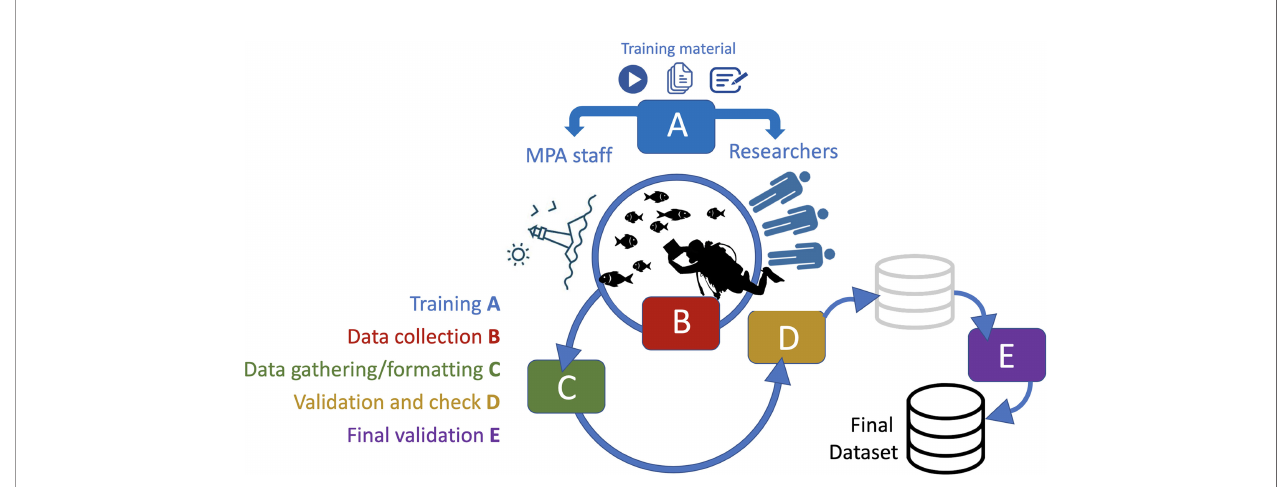
FIGURE 1 | ClimateFish work fl ow. Visual representation of the data curation, formatting, technical validation, and quality control process of the database: (A) Training sessions/materials were delivered to both MPA staff and collaborating researchers; (B) Data were collected by trained scientists and technicians, according to the protocol described in Garrabou et al. (2018) and checked before submission; (D) Formatted data were then examined for possible errors and underwent the technical validation process. The data providers were contacted in case of doubts or errors; (C) Data were gathered and formatted to meet Darwin Core archive standards (https://www.tdwg.org/standards/dwc/) and reports which did not meet inclusion criteria were removed (see Technical Validation section); (E) After the technical validation process, data were manually examined to detect any remaining error. The fi nal database was published at the end of this repeated validation and quality check process and is freely accessible at: